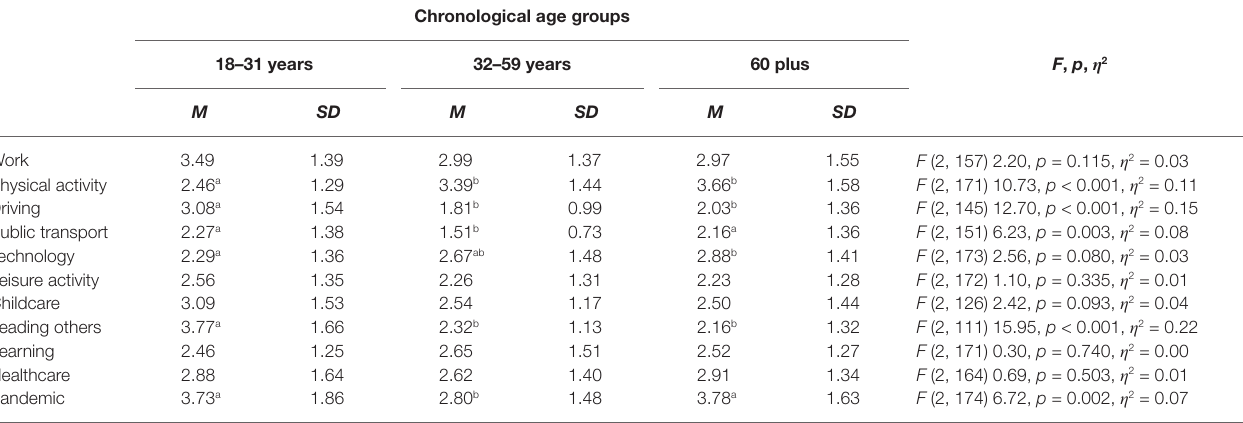
Different letters in the same row indicate significant pairwise comparisons p < 0.05.